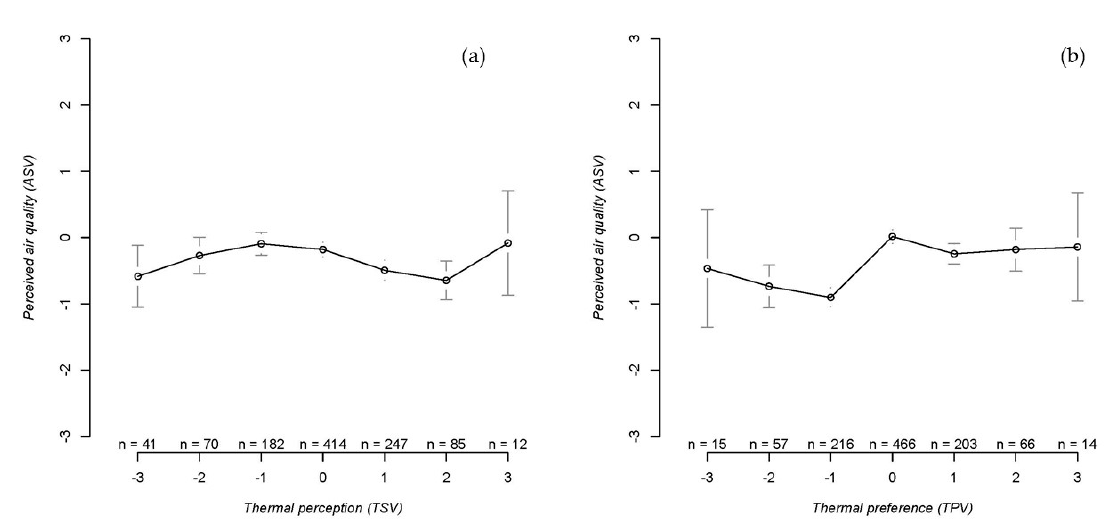
Figure 9. Perceived air quality for: ( a ) thermal perception votes; ( b ) for thermal preference votes, for Stage 2 (n shows the number of responses).